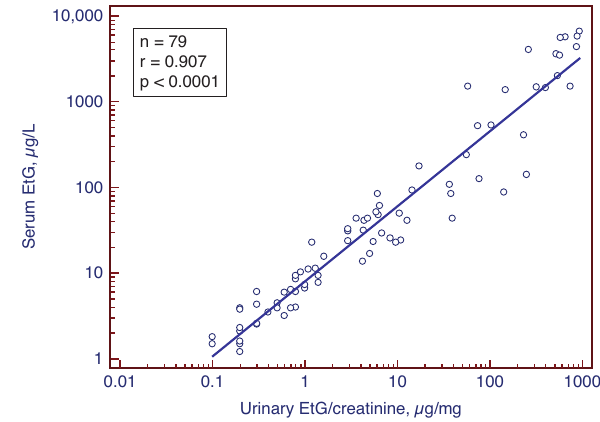
Figure 3: The correlation between EtG in whole blood and time since hospitalization presented in semilogarithmic scale. The regression line indicates an elimination half-life of 16 h. The figure includes the data including the first negative sample set to a value of 0.9 μ g/L.